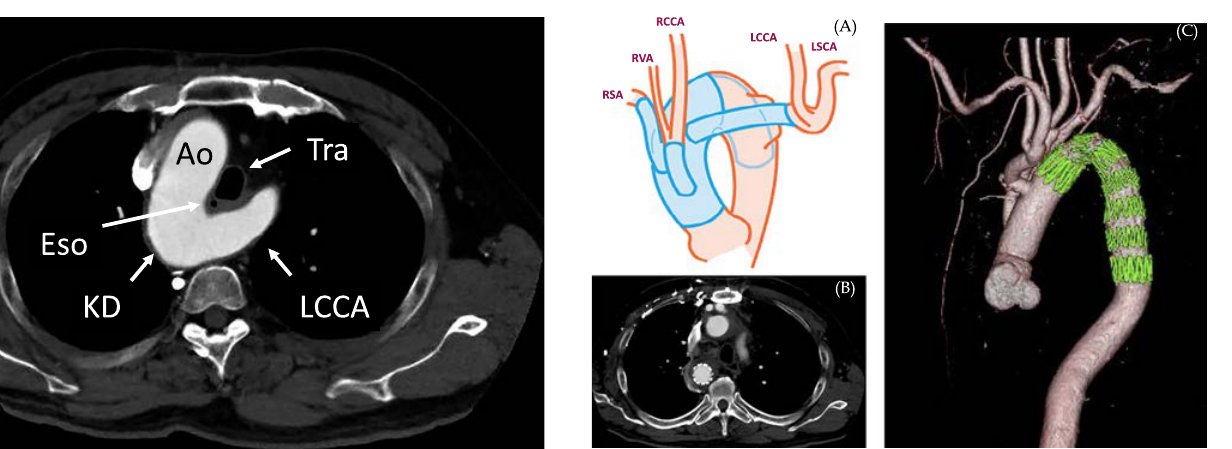
Figure 1 Axial computed tomography angiography showing a 26-mm aneurysmal Kommerell diverticulum (KD) with right aortic arch (Ao). The esophagus (Eso) is compressed by the trachea (Tra), and the KD connects to the common carotid artery (LCCA).